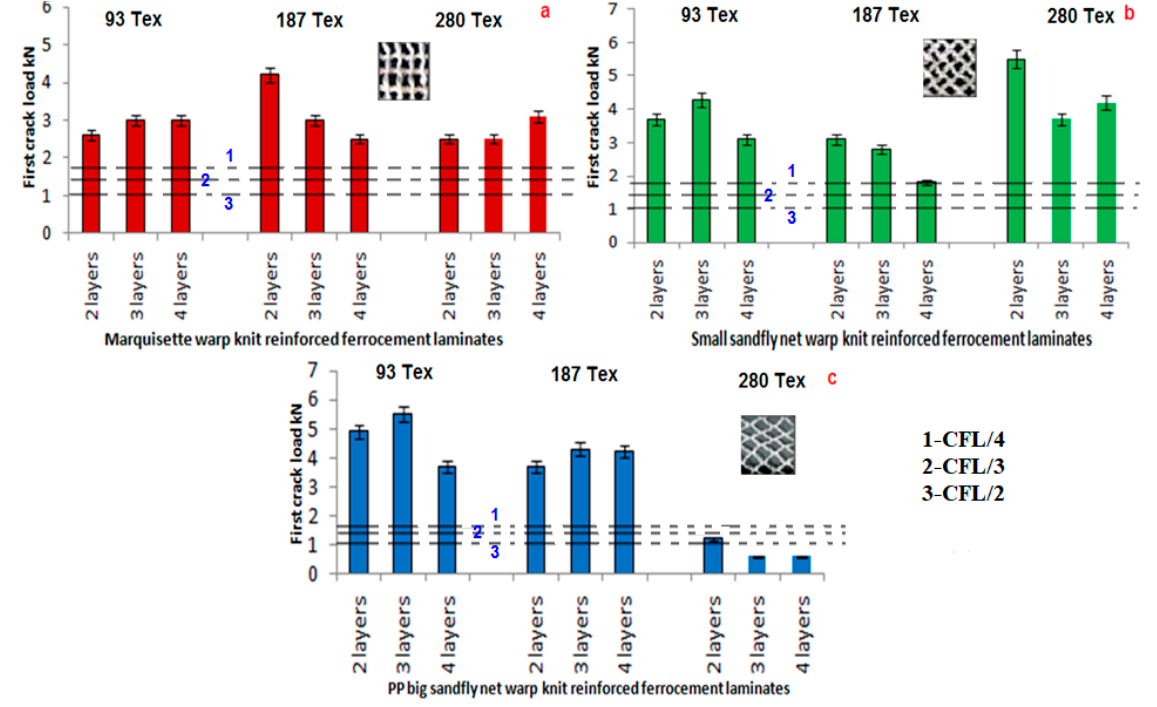
Figure 7. First crack load analysis of ( a ) marquisette, ( b ) small sandfly, and ( c ) big sandfly net polypropylene warp knitted reinforced ferrocement laminate.